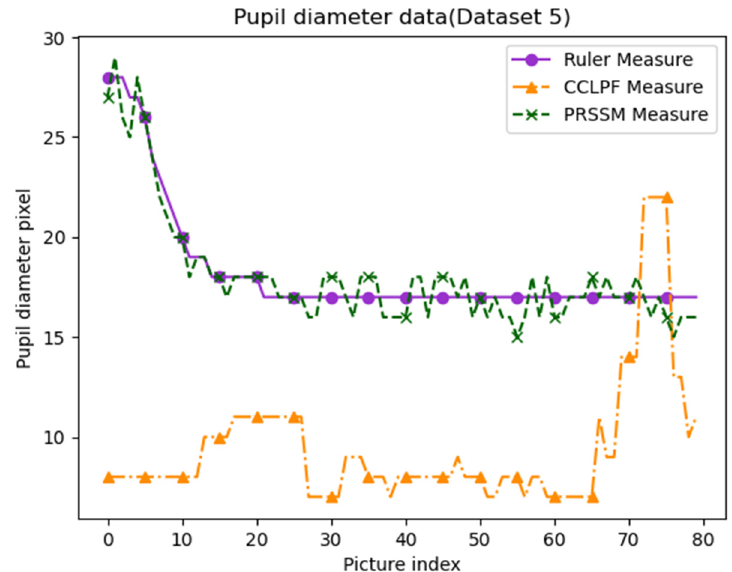
Figure 45. Pupil diameter graph for Data Set 5.